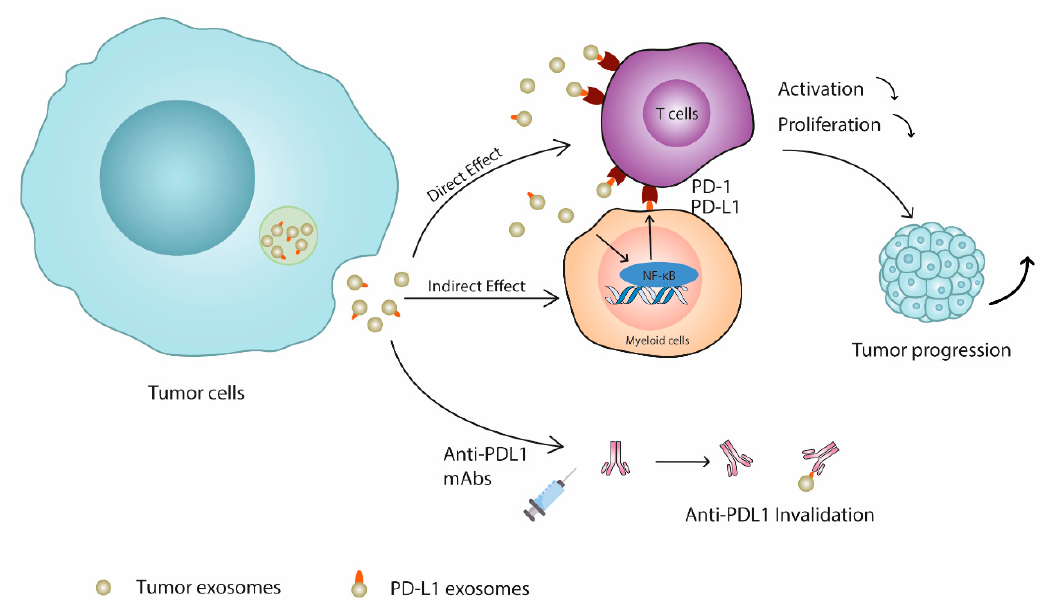
Figure 1. Mechanisms of exosomal PD-L1 mediated immunosuppression. In general, the interaction between exosomal PD-L1 and PD-1 on T cells directly causes immunosuppression. In addition, exosomal PD-L1 up-regulates the expression of PD-L1 in myeloid cells through the NF- κ B pathway, makes them transform into myeloid immune cells, and indirectly inhibits the activation and proliferation of T cells. Besides, exosomal PD-L1 can be blocked by anti-PD-L1 mAbs, which may result in a low response rate to anti-PD-L1 mAb treatment. The end point of these mechanisms is T cell inactivation and tumor progression.